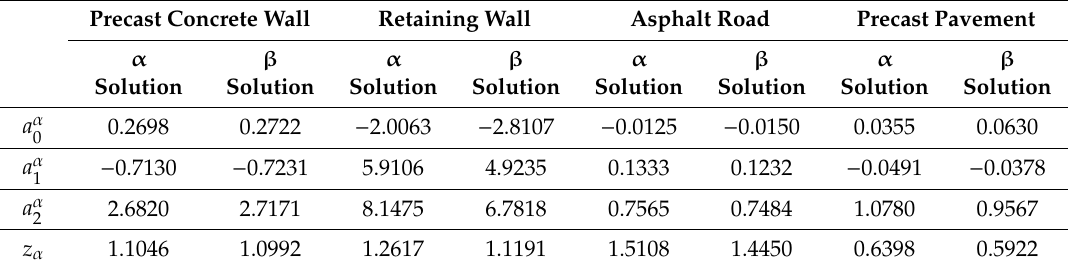
Table 2. Plane parameters respectively for the α solution and β solution.